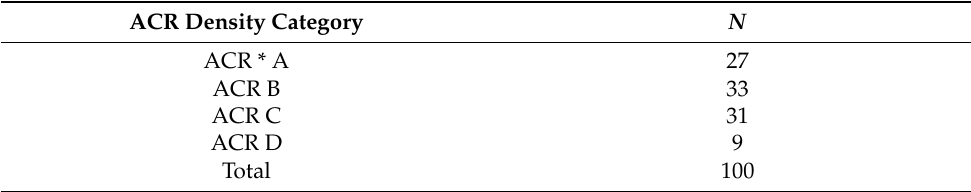
Table 1. The distribution of the mammographic BC types in the test set.